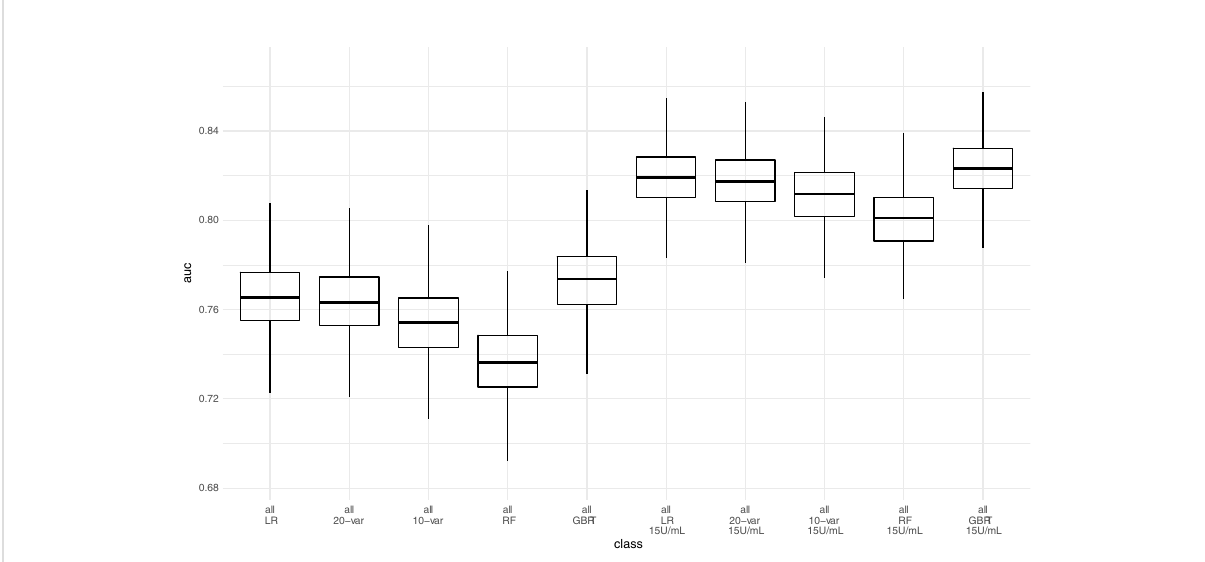
FIGURE 5 Predictive performance of the 10-variable, 20-variable LASSO logistic regression, logistic regression (LR), random forest (RF) and gradient boosted regression tree (GBRT) models on the pooled validation set comprised of all 4 validation sets with cutoff 0.8 U/mL and 15 U/mL for the